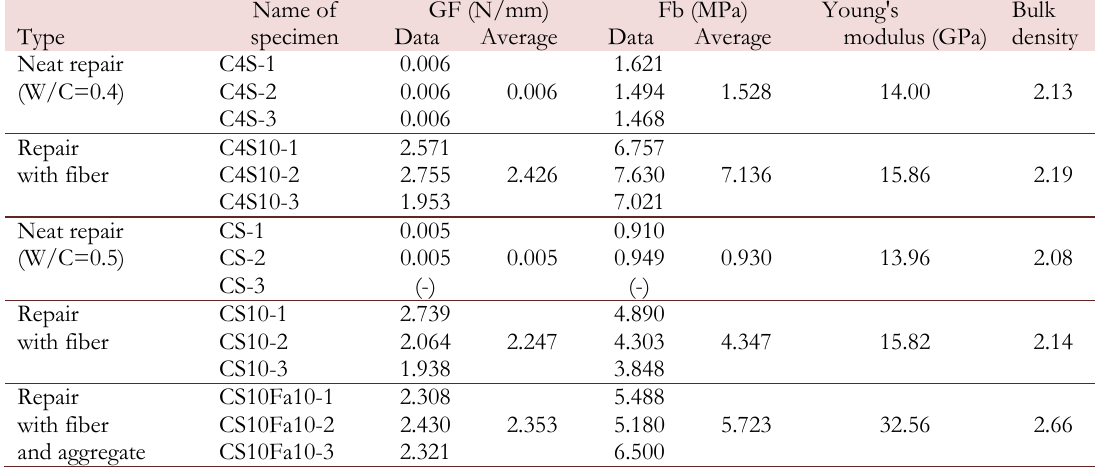
Table 2: Mechanical properties of repair